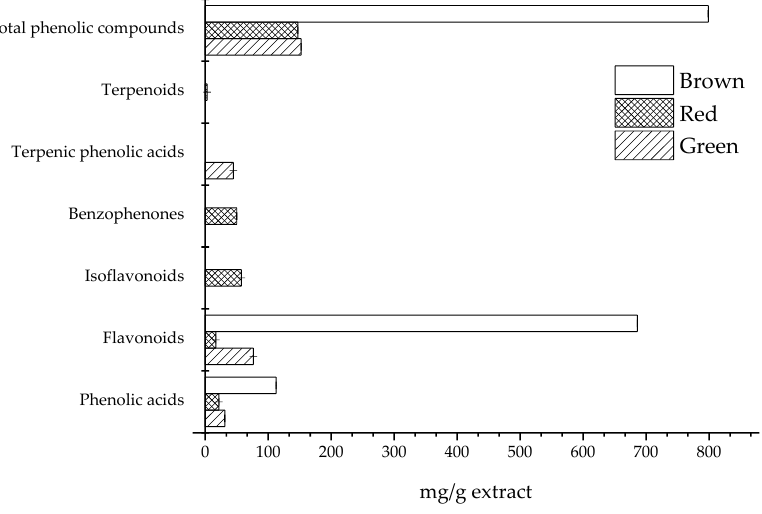
Figure 1. Main classes of phenolic compounds found in green, red and brown propolis.